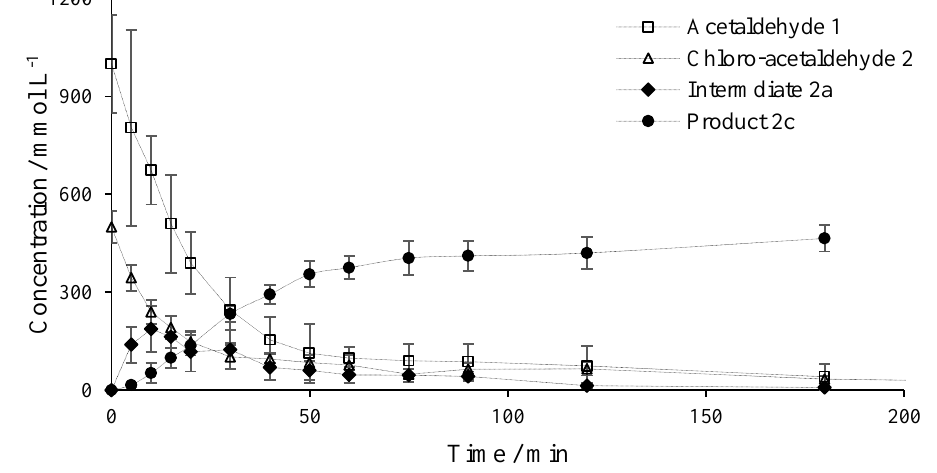
Figure 7. Time course of conversion of acetaldehyde 1 with DERA to the dimer 1a , and subsequently to the lactol 1c , at the optimized reaction conditions (32 °C, pH 7.5) based on the DoE, 5 mL of final volume, 0.1 M of TEOA buffer, 1.5 M of substrate concentration, 70 µL of DMSO, and 100 mg of DERA in freeze-dried E. coli cells.